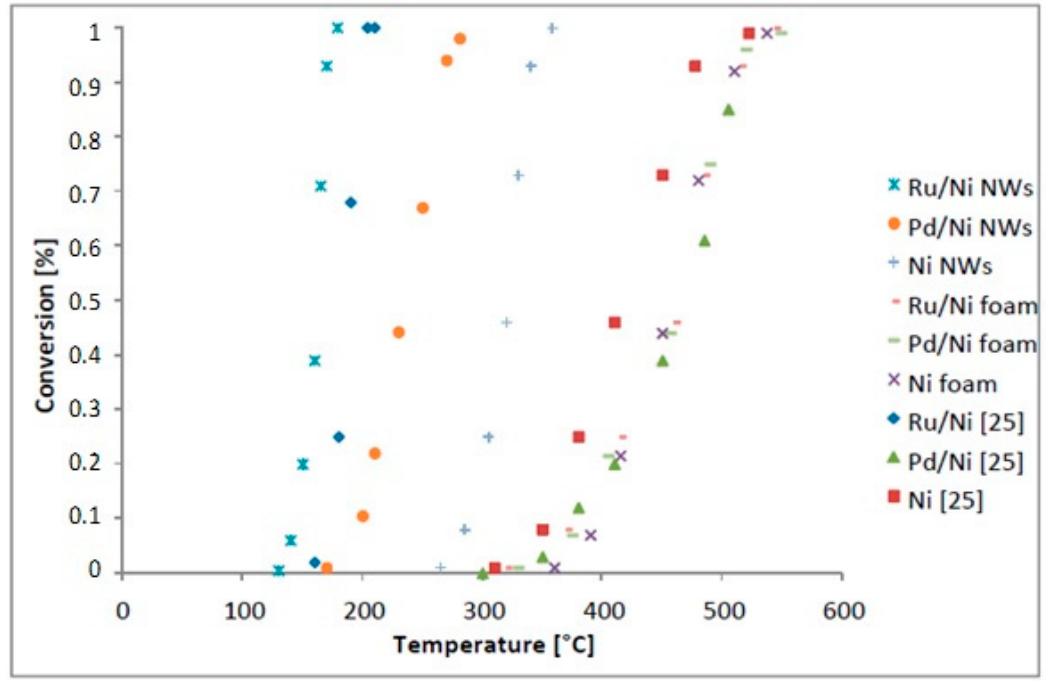
Figure 6. CO 2 conversion of the new catalysts and those that were reported in Reference [25].